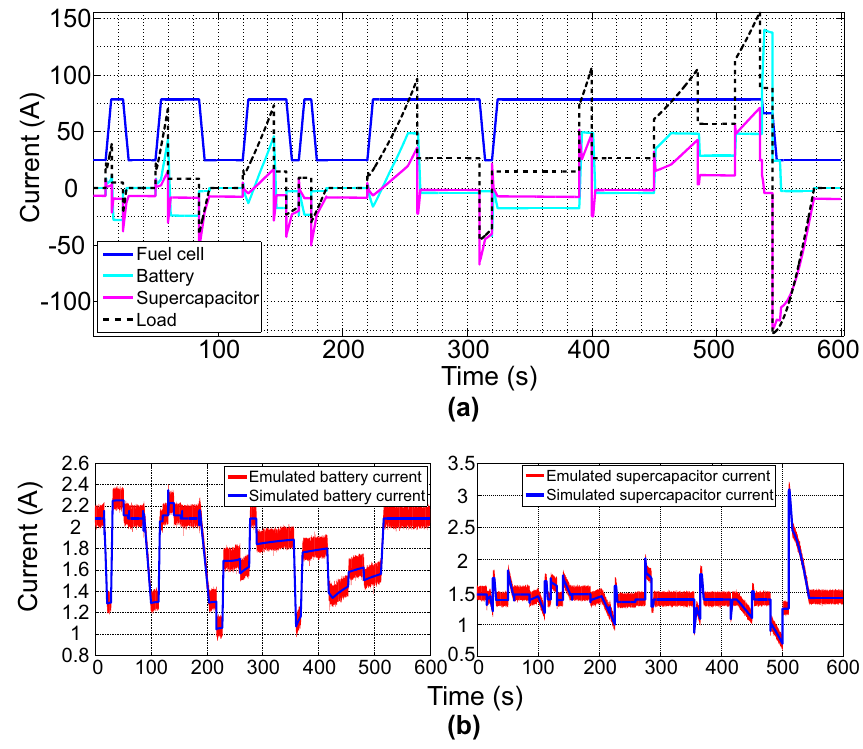
Figure 20. ( a ) Simulated source and load current; ( b ) experimentally-emulated battery and supercapacitor